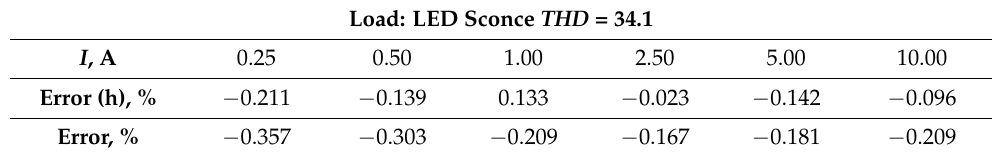
Table 3. Dependence of the electronic energy meter errors on the current value for THD = 34.1. Load: LED Sconce THD = 34.1